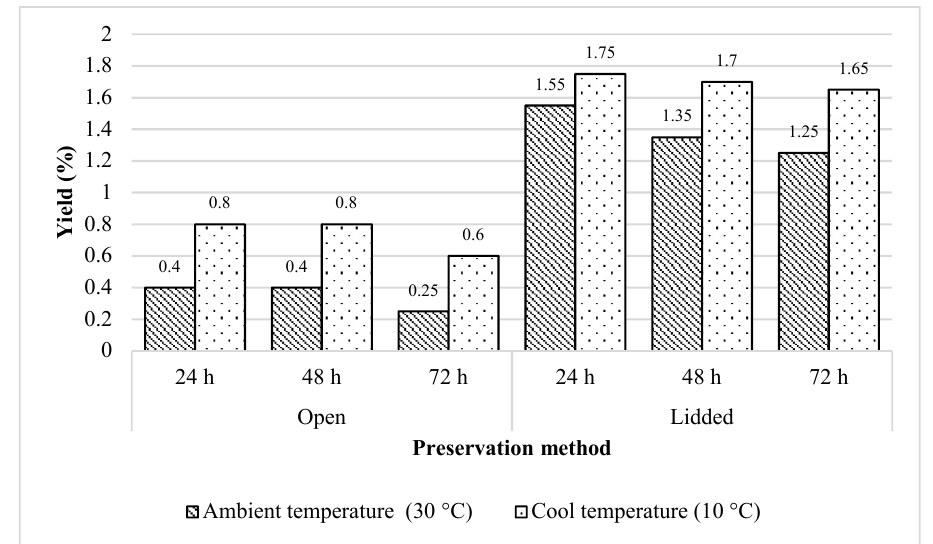
Figure 4. The influence of the preservation method on the yield of essential oil.